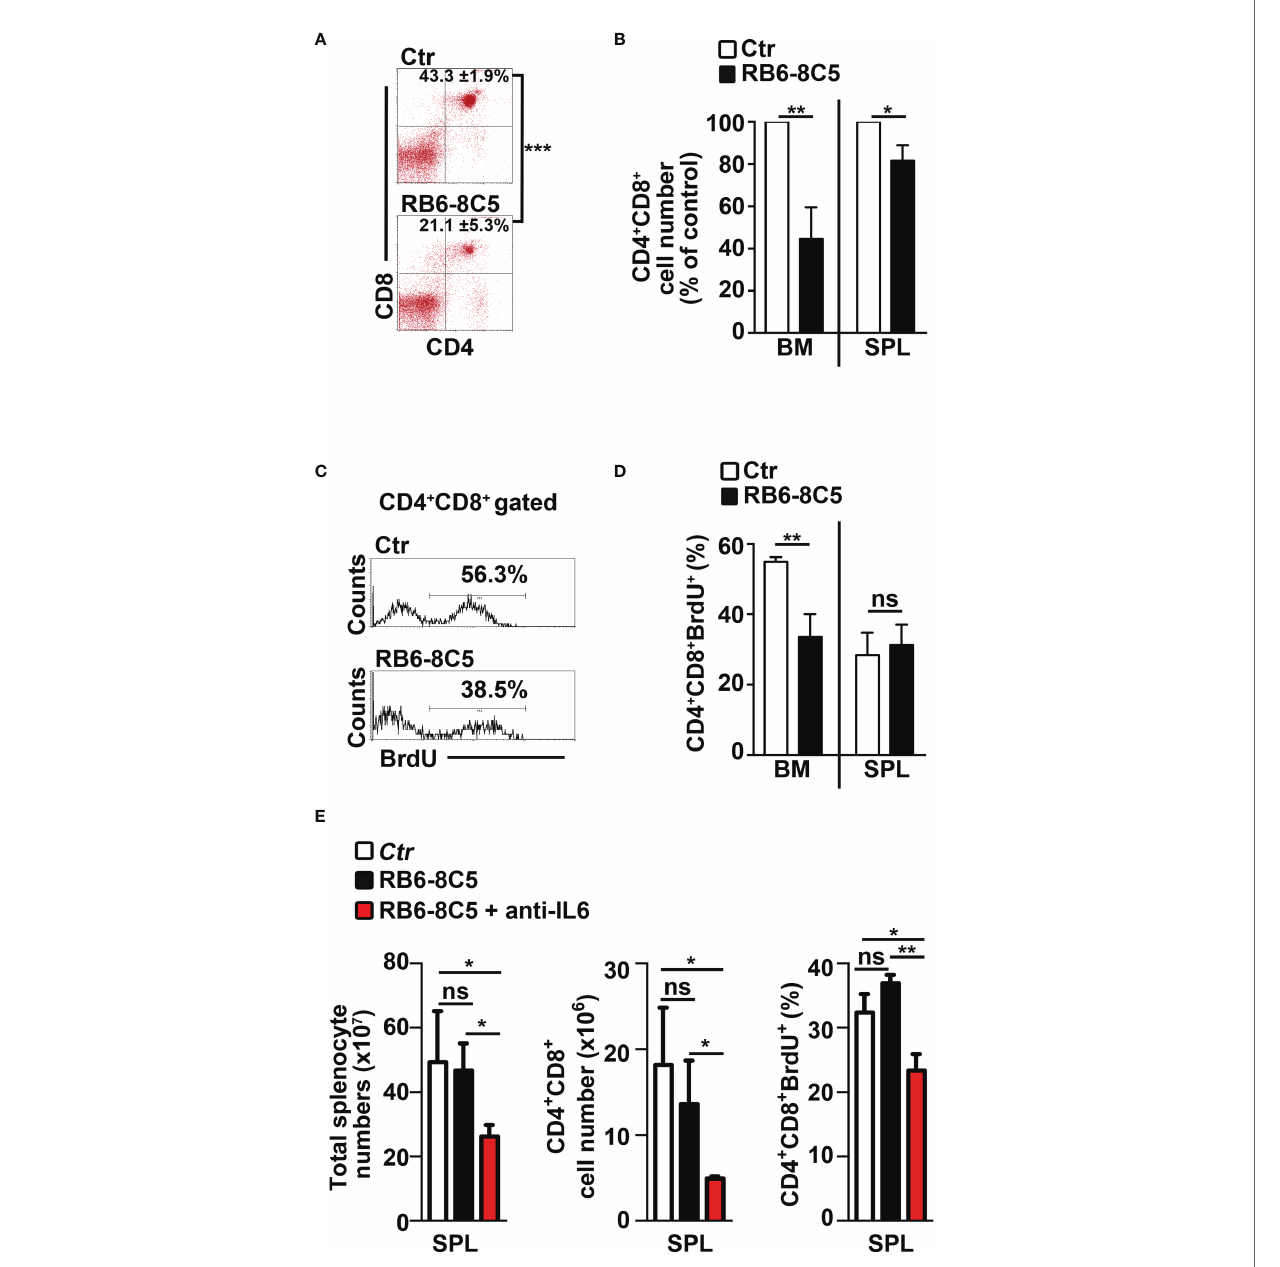
FIGURE 6 | Gr-1 depletion affects CD4 + CD8 + (DP) T cells in N3-tg mice. N3-tg mice were injected i.p. with anti-Gr-1 depleting antibodies (RB6-8C5) or isotype controls (Ctr), twice a week and sacri fi ced/analyzed after 4 weeks of treatment; some of the mice were also injected i.p with BrdU solution 1 day before the sacri fi ce. (A) Percentages of CD4 + CD8 + cells are shown, as measured by FACS analysis in the BM of N3-tg mice, treated as above. Numbers inside cytograms indicate the mean percentages ± SD of CD4 + CD8 + cells. (B) The graph reports the ratio between the CD4 + CD8 + cell counts in RB6-8C5-treated N3-tg mice and in relative controls, expressed as % of control, and calculated in the BM and spleen (SPL), by the same FACS analysis, as in (A) . In (A, B) , the data are presented as the mean value ± SD from three independent experiments ( n = 4 mice per group). (C) Representative FACS analysis of BrdU + cells inside the CD4 + CD8 + subset in the BM of N3-tg mice, treated as above, with isotype control antibodies (Ctr) or anti-Gr-1 depleting antibodies (RB6-8C5). Numbers inside cytograms indicate the percentages of CD4 + CD8 + BrdU + cells. (D) The graphs show the CD4 + CD8 + BrdU + cell percentages in the BM and spleen (SPL) of N3-tg mice, treated as above, and measured by the same FACS analysis, as in (C) . We have not observed any effects of anti-Gr-1 treatment on T-cell compartment of wt mice (not shown). (E) The graphs report total cell counts (left panel), absolute numbers of DP T cells (middle panel), and percentages of BrdU + DP T cells (right panel), in mice injected with RB6-8C5 antibodies alone (black bars), or in combination with anti-IL-6 antibodies (red bars), compared with controls (white bars). In (D, E) , the results are presented as the mean value ± SD from two independent experiments ( n = 3 mice per group). ns, not signi fi cant, p > 0.05; * p ≤ 0.05; ** p ≤ 0.01, and *** p ≤ 0.001 represent signi fi cant differences between the indicated